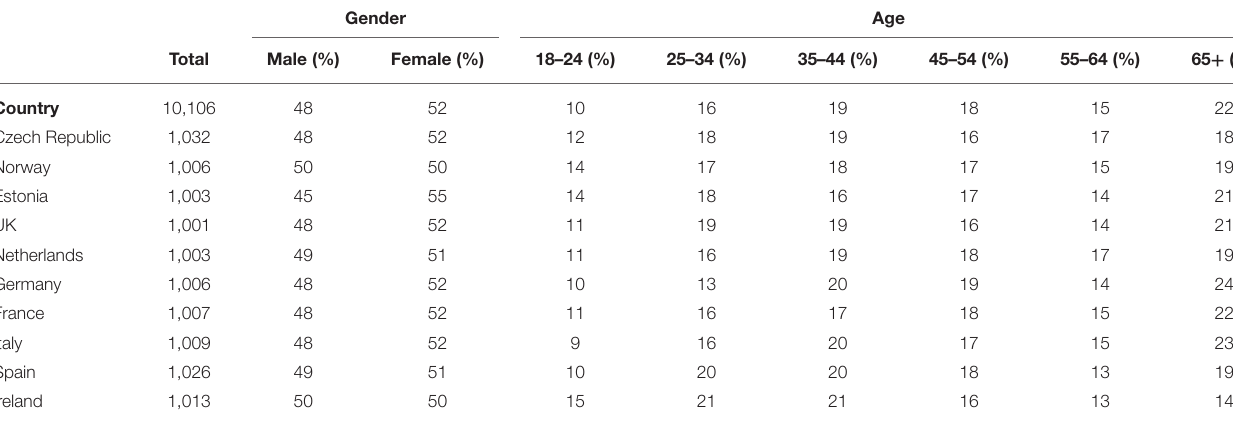
TABLE 1 | Age and gender split of the interviewees in the nationally representative samples for each country